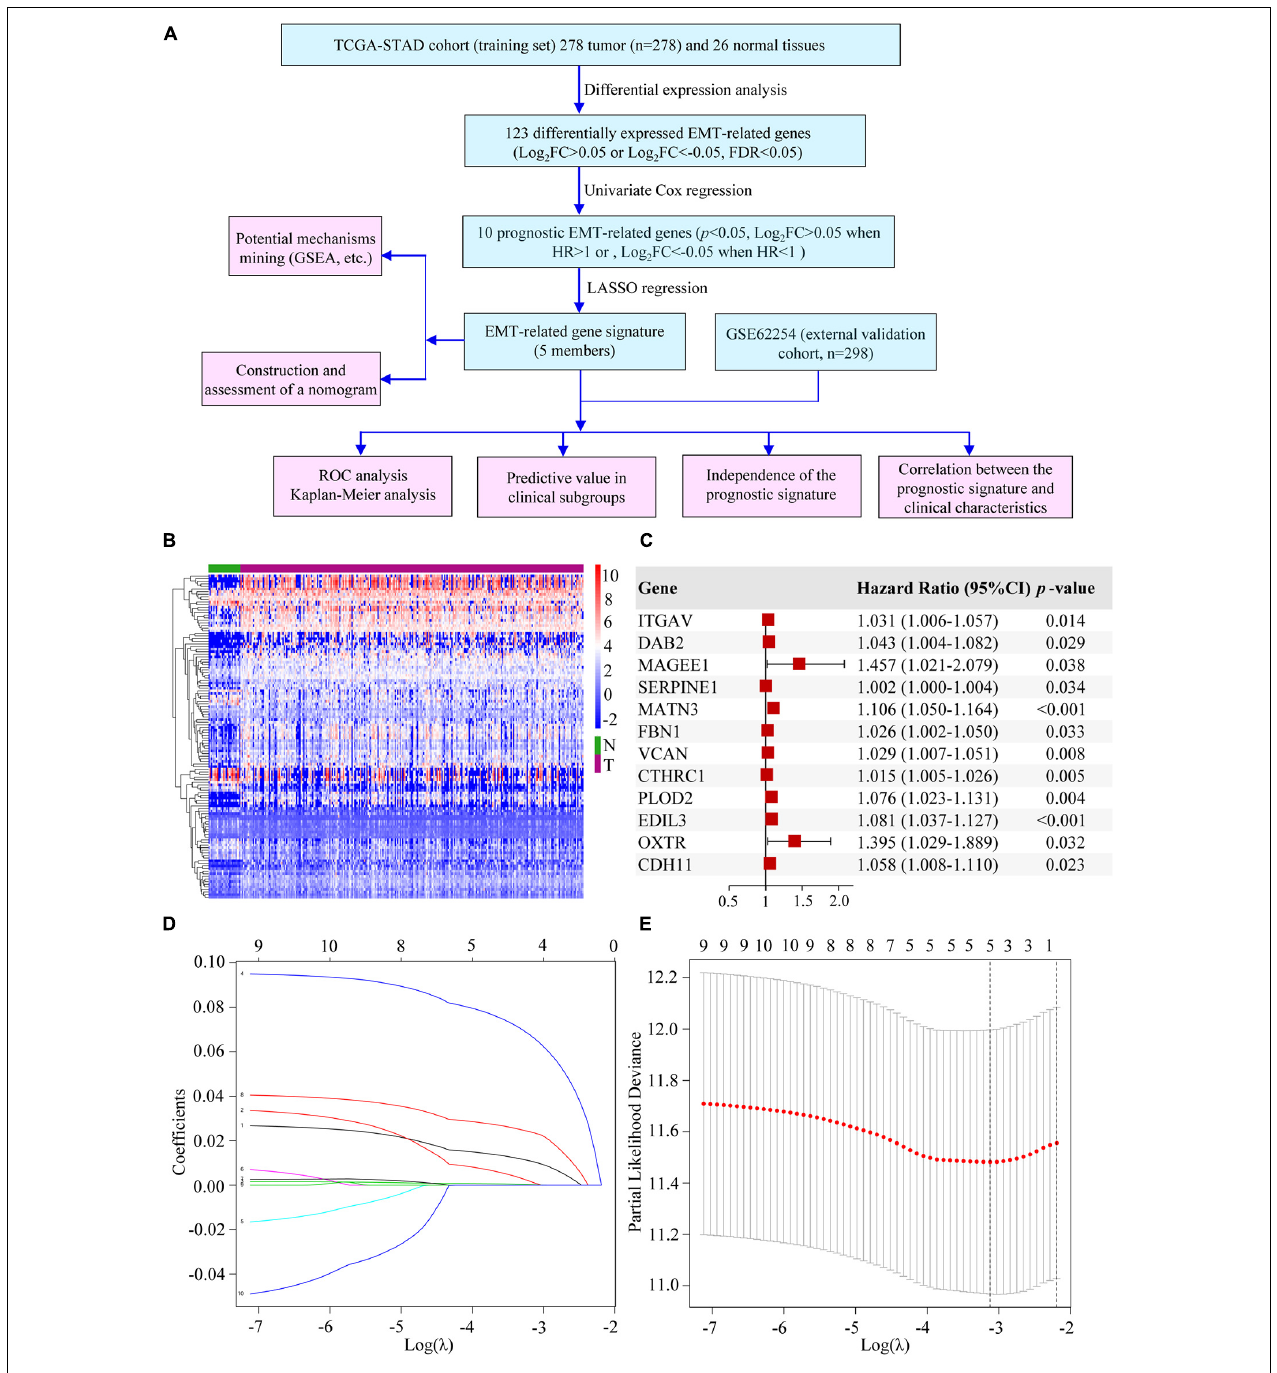
FIGURE 1 | Establishment of the EMT-related gene signature. (A) The flow chart of our study. (B) Heatmap of DEEGs. (C) Univariate Cox regression analysis of DEEGs associated with OS in GC. (D) LASSO coefficient profiles of 10 prognostic genes of GC. (E) LASSO regression with ten-fold cross-validation obtained 5 prognostic genes by using the minimum λ